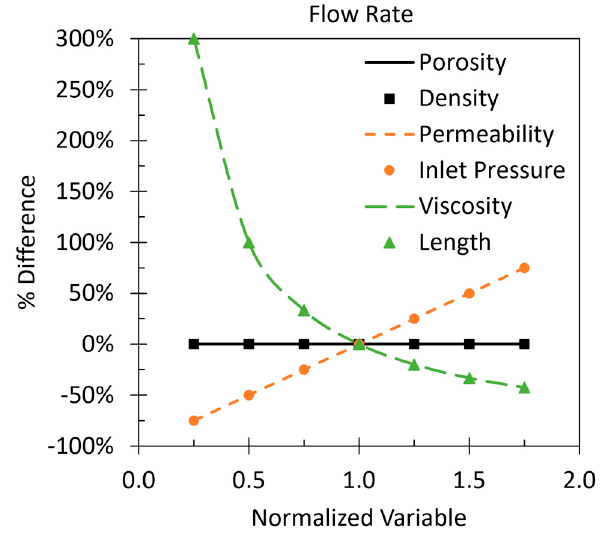
Figure 9. Parametric study of the system variables with respect to steady-state flow rate.